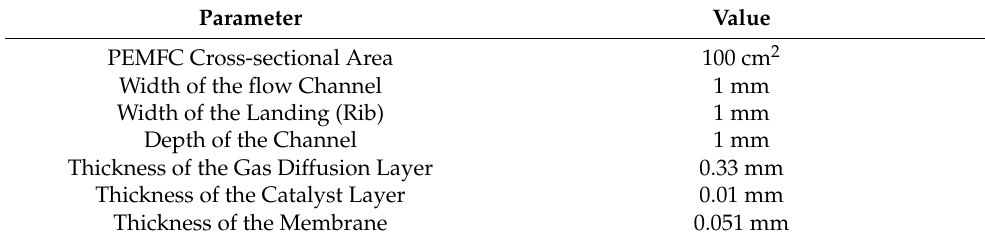
Figure 2. Flow channel design. ( a ) 2-Serpentine. ( b ) 3-Serpentine. ( c ) Serpentine zigzag. ( d ) Straight zigzag. ( e ) Straight zigzag. Table 1. Design